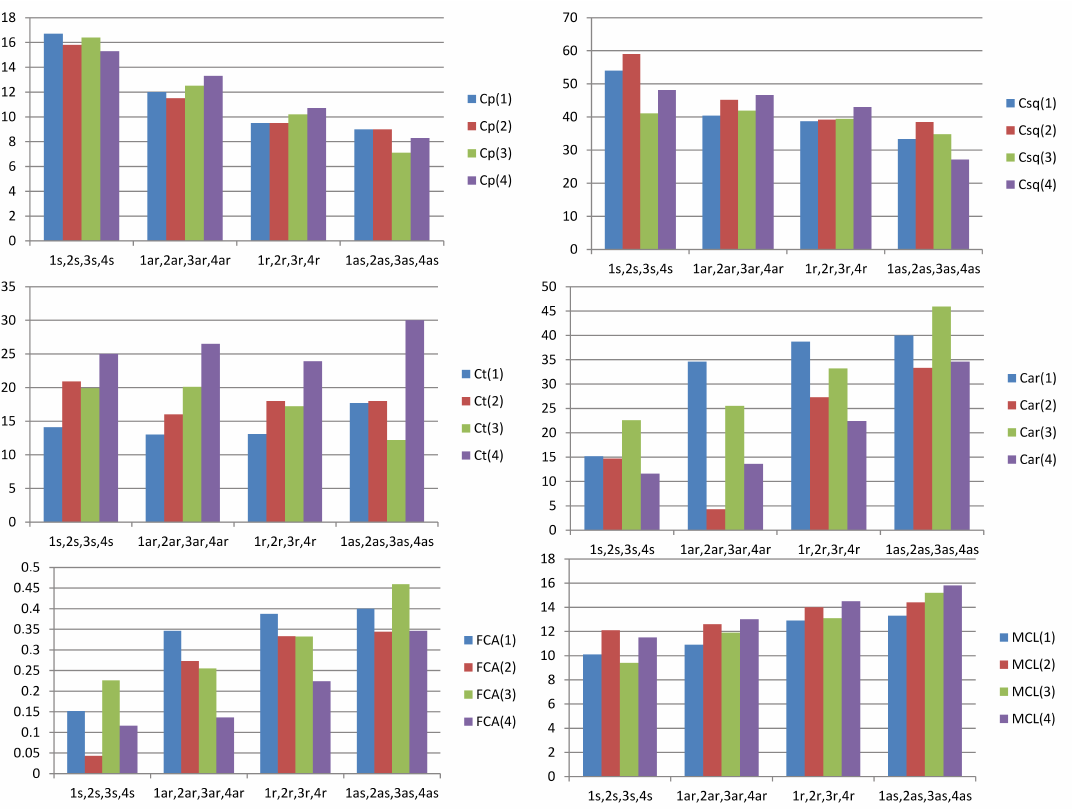
Figure 6. Diagram of changes of obtained parameters C p , C sq , C t , C ar , F CA , and MCL for the studied samples of oil